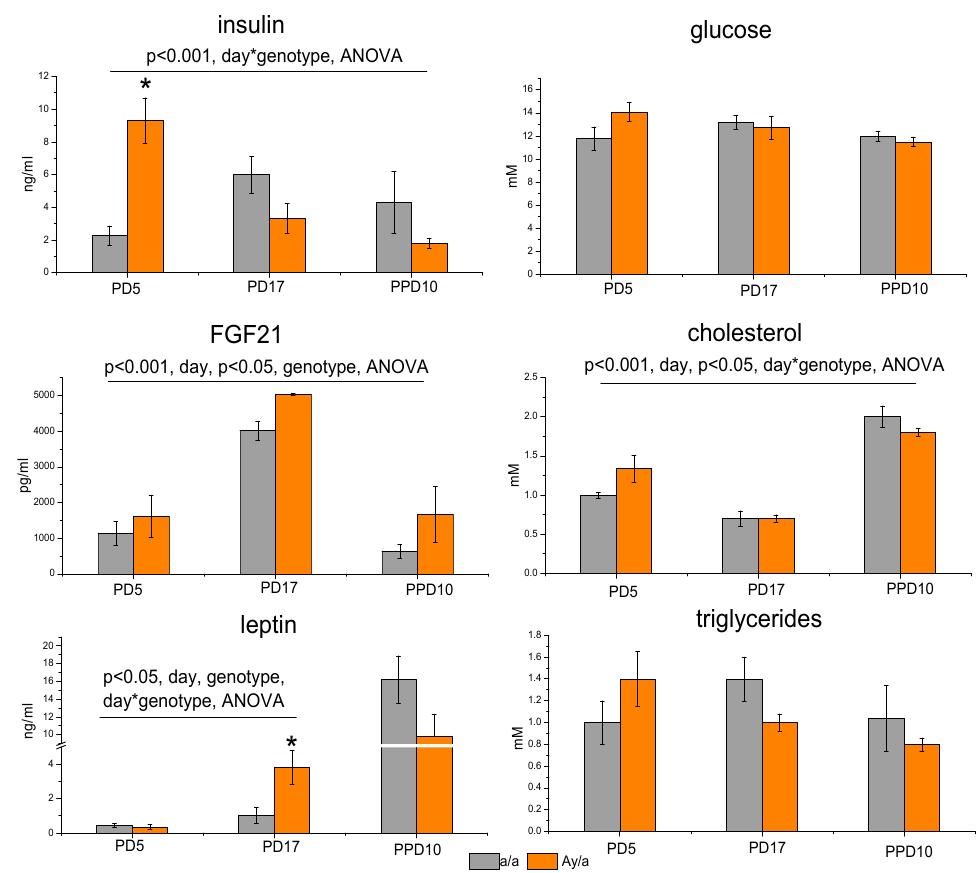
Figure 1. Hormonal and metabolic characteristics of females during pregnancy and lactation: * p < 0.05; post hoc Newman–Keuls test between a/a and A y /a ; PD5,17—pregnancy day 5, 17; PPD10—postpartum day 10. Data are presented as mean ± SE for 7 mice in each group. Data were analyzed with two-way ANOVA with factors “day” (PD5, PD17, and PPD10) and “genotype” ( a/a and A y /a ).